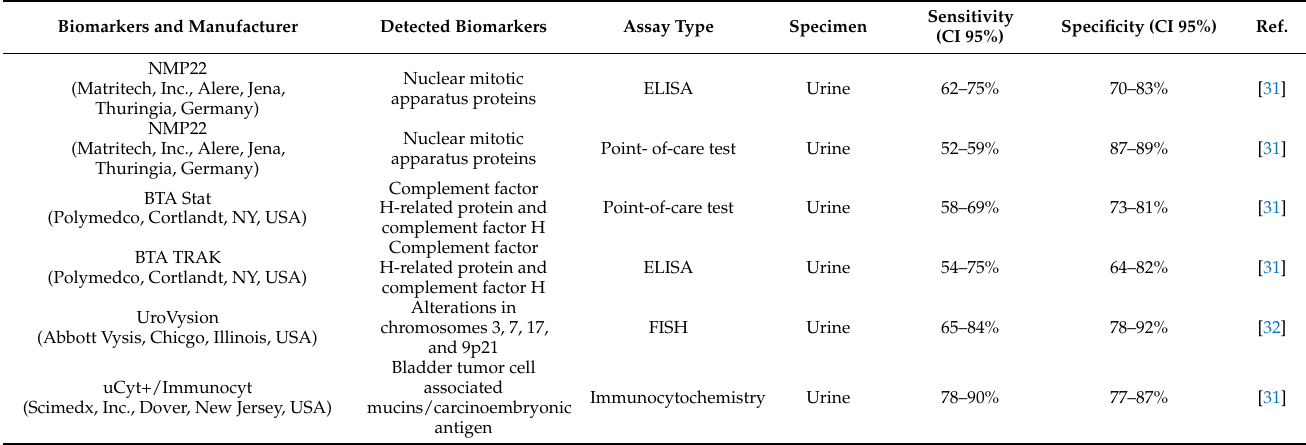
Table 1. FDA-approved